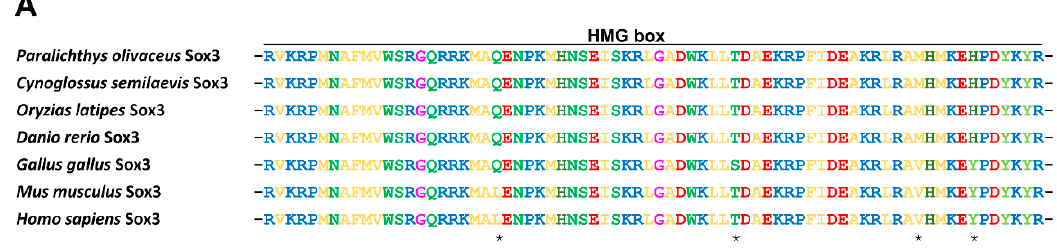
Figure 2. Cont. Figure 2. Cont.